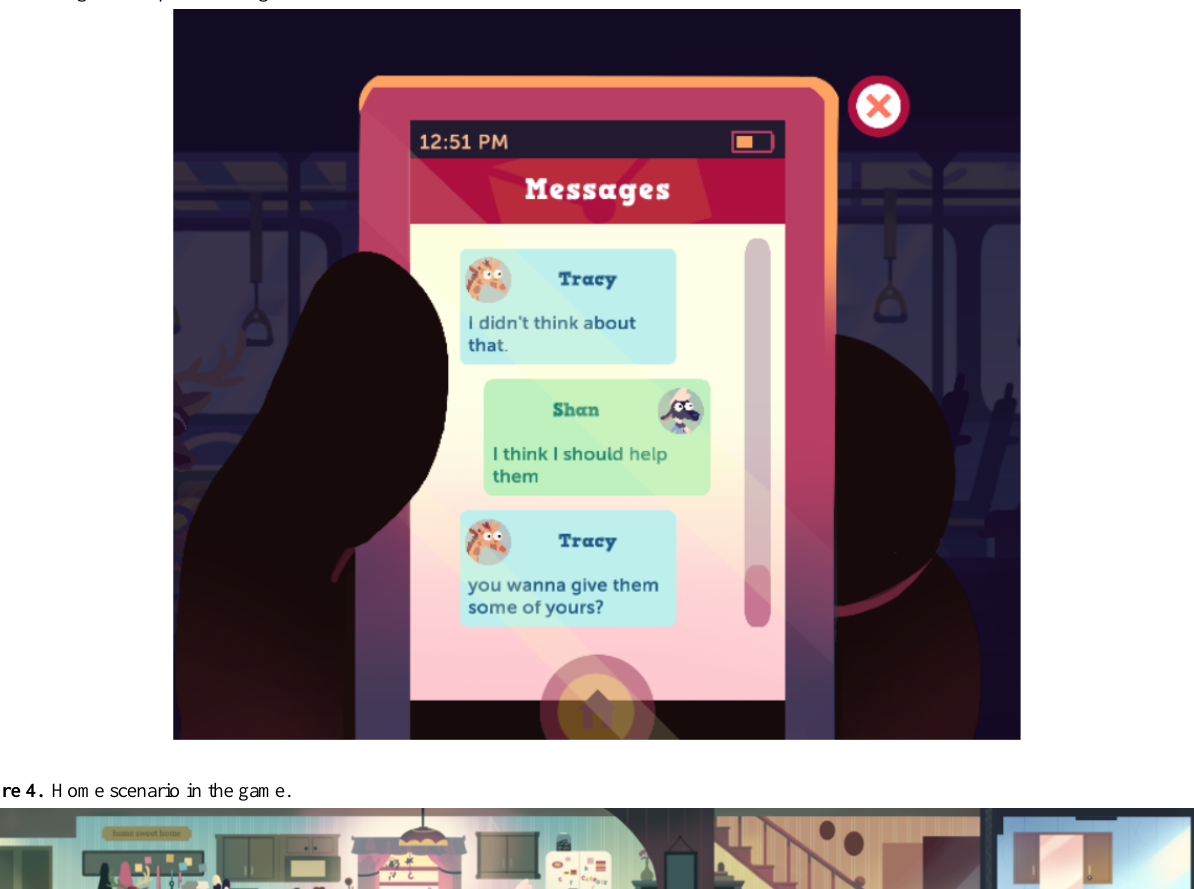
Figure 3. In-game cellphone dialogue.